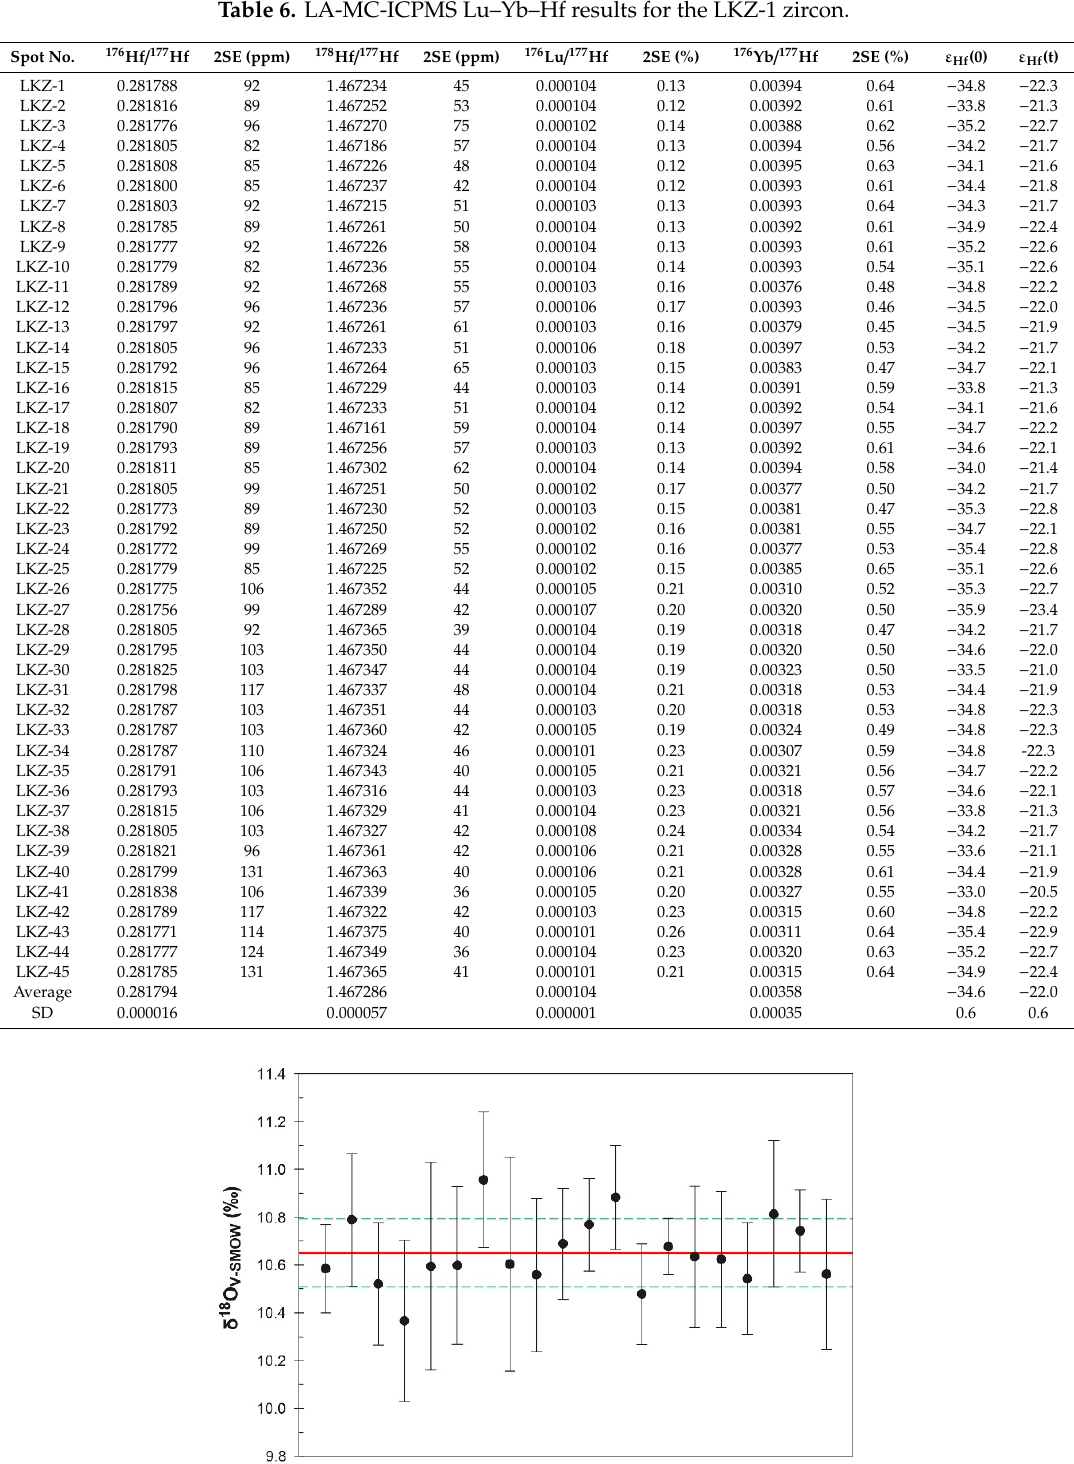
Figure 5. O isotopic variation in the LKZ-1 zircon based on HR-SIMS analyses. Vertical error bars denote 2 standard errors. Solid and dashed lines represent the average (10.65‰) and standard deviation (±0.14‰), respectively. The LA-MC-ICPMS analyses produced an average 176 Hf / 177 Hf of 0.282294 ± 0.000021 (n = 41) for the 91500 zircon (Table S3), which was consistent with the MC-ICPMS result obtained by